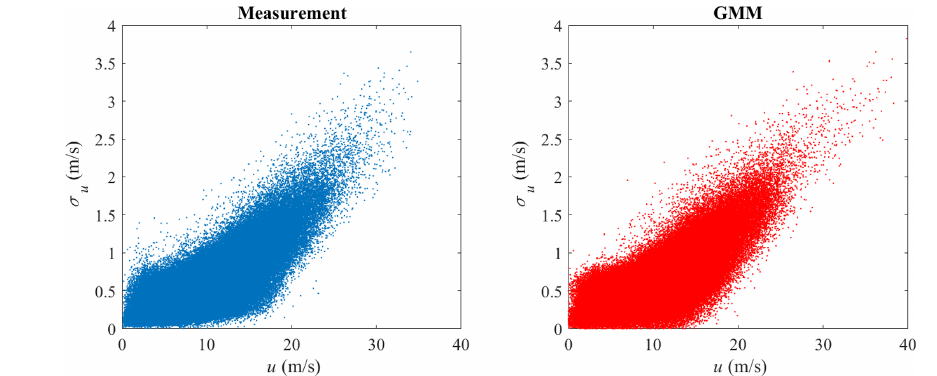
Figure 9. Measurement data and GMM random sample for the offshore sector.